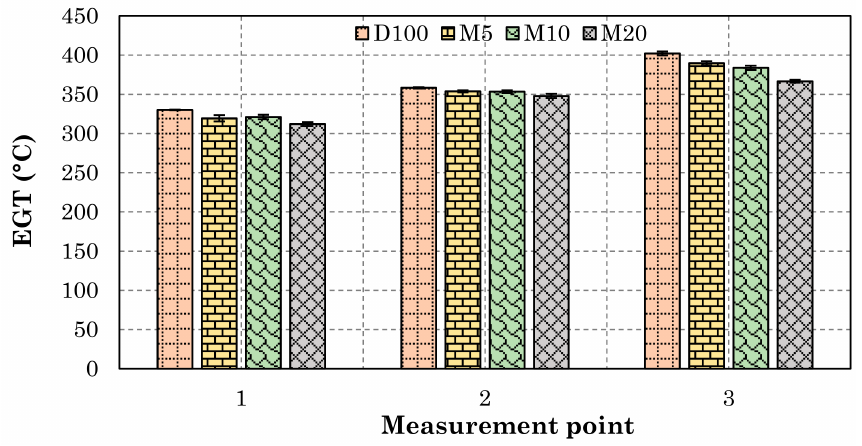
Figure 13. Exhaust gas temperature (EGT) for all test fuels at all measurement points (error bars represent the standard deviation).